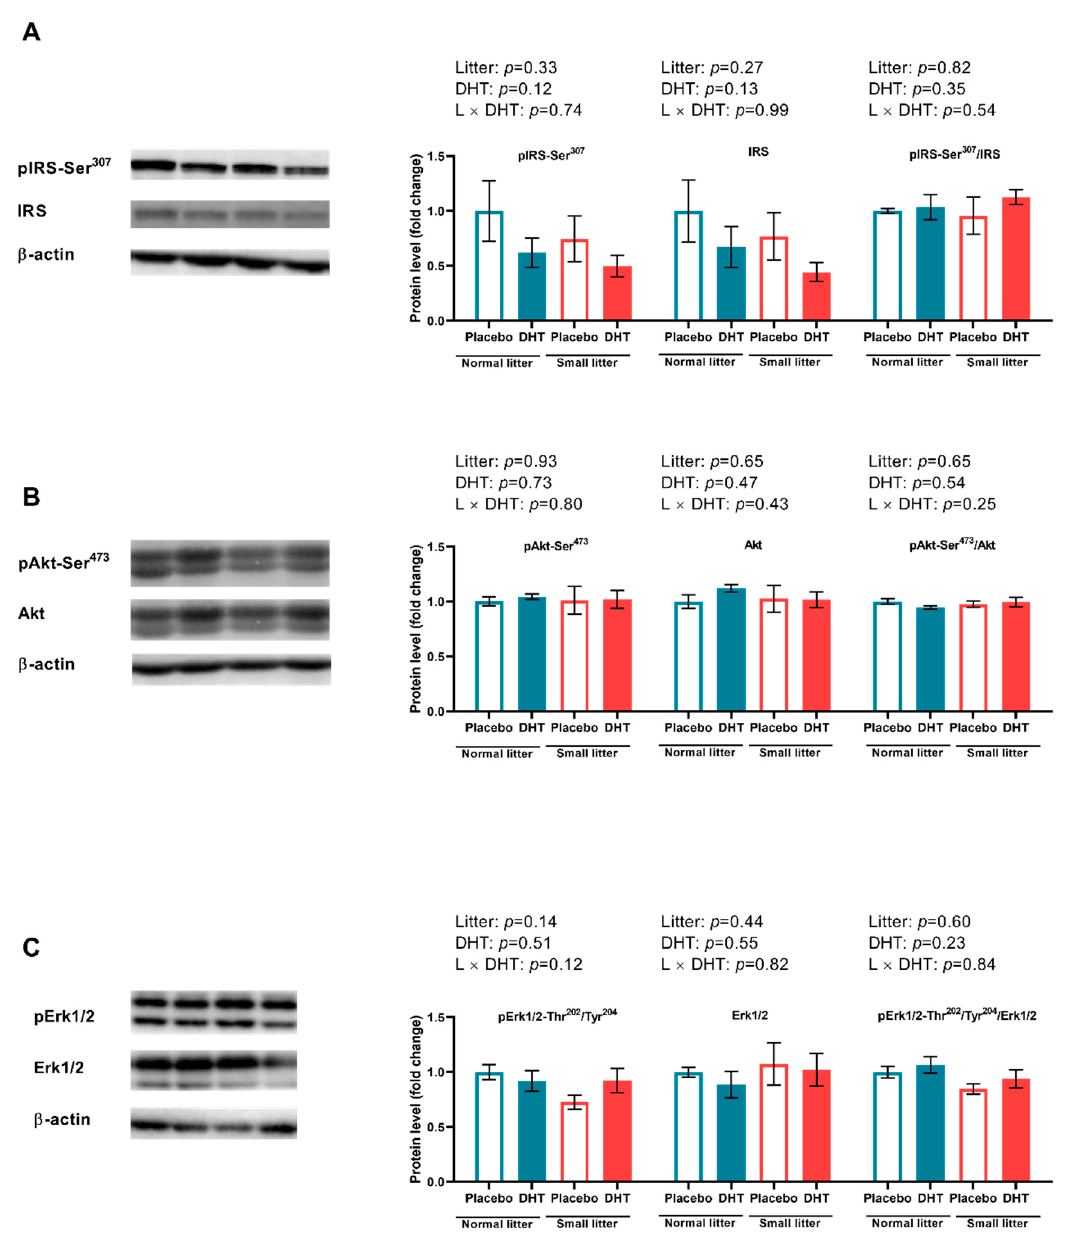
Figure 3. Insulin signaling in VAT of placebo and DHT treated rats from small and normal litters. ( A ) Protein levels of pIRS1-Ser 307 , IRS1 and their relative ratio with representative Western blots; ( B ) Protein levels of pAkt-Ser 473 , Akt and their relative ratio with representative Western blots; ( C ) Protein levels of pErk1/2-Thr 202 /Tyr 204 , Erk1/2 and their relative ratio with representative Western blots. All protein levels were measured in cytosol of the VAT and normalized to β actin. The data are presented as mean ± SEM ( n = 6 animals per group). To determine the effects of litter size reduction and DHT treatment, as well as their interaction, two-way ANOVA was done, and the difference was considered significant at p < 0.05.